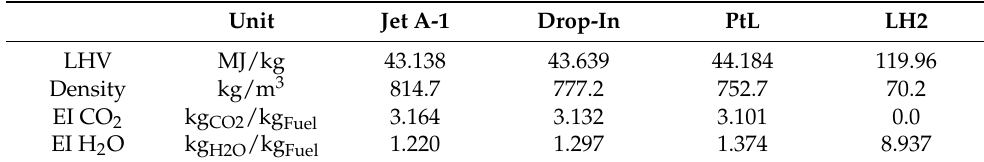
Table 1. Key characteristics and emission properties of applied energy carriers. Unit Jet A-1 Drop-In